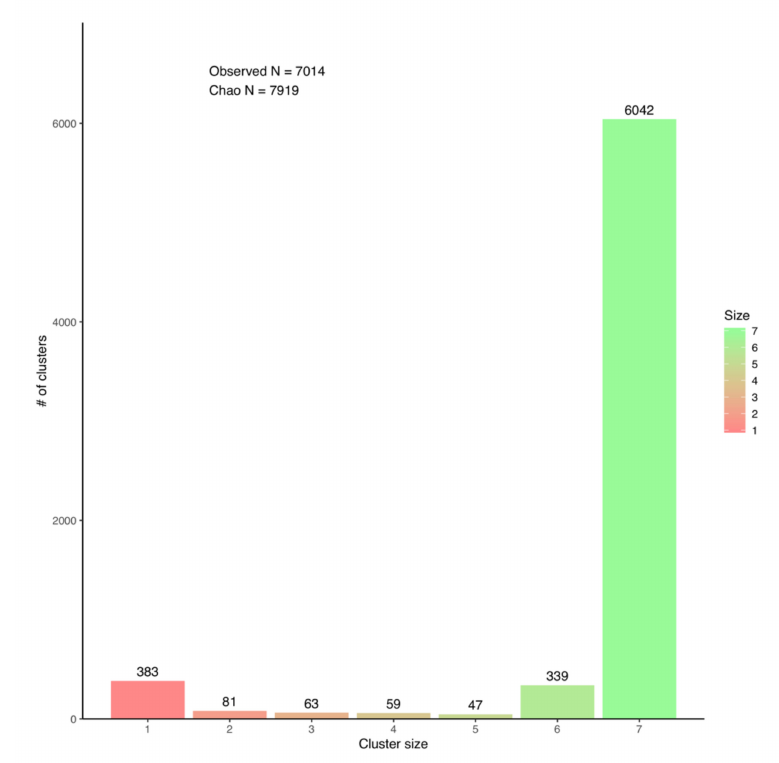
Figure 3. Bar chart representing the distribution of syntenic cluster sizes within Yarrowia lipolytica pan-genome and Chao’s lower bound estimation of true pan-genome size. Figure generated by